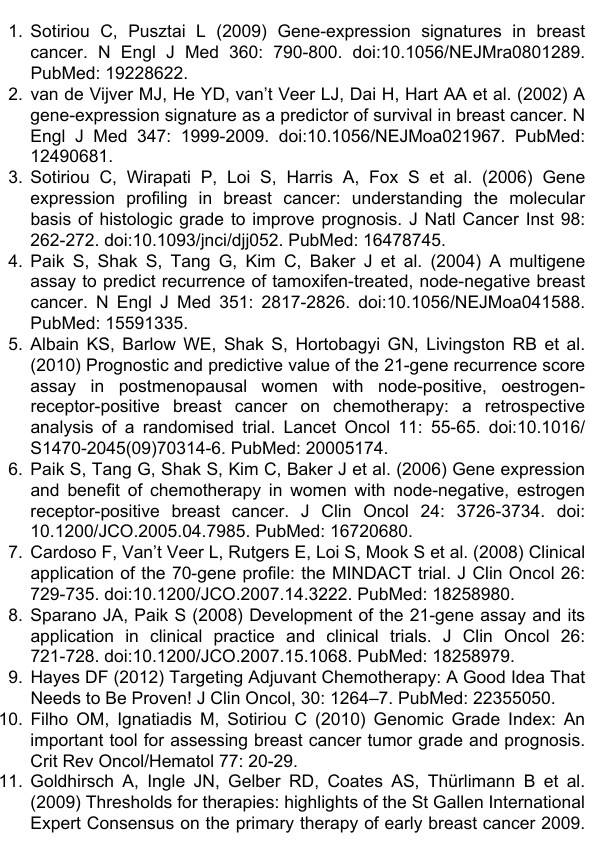
Table S1. Map Quant Dx